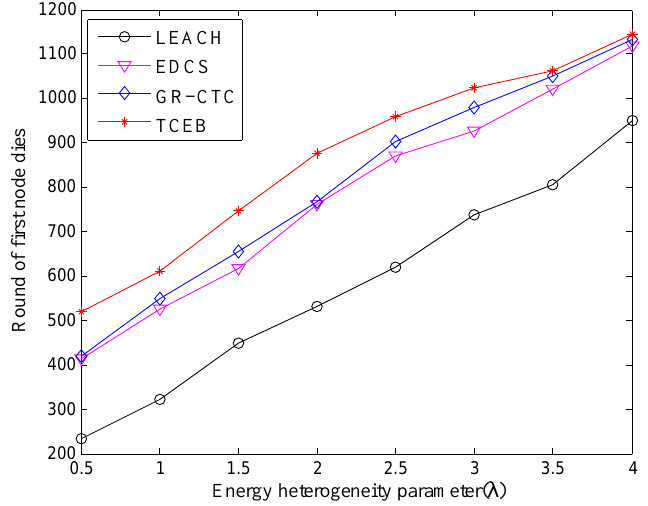
Figure 9. The comparison of stable period under different energy heterogeneity factor ( n = 200 ) .